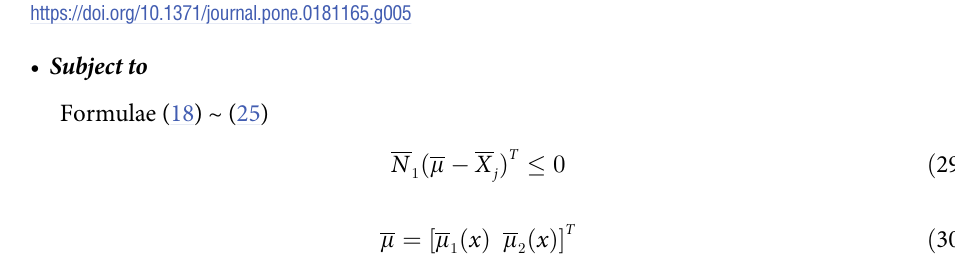
Fig 5. The Pareto frontier and the Utopia line in the normalized objective